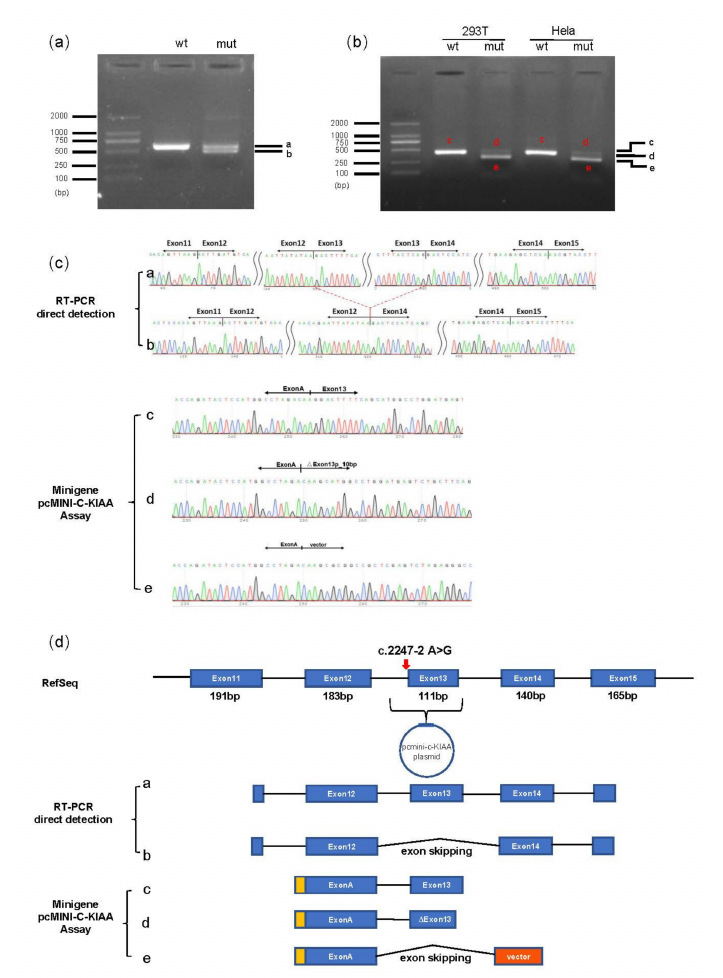
Figure 4. Blood RT-PCR and minigene assay analysis of the KIAA0825 c.2247-2A>G variant: ( a ) Elec- trophoresis results of the RT-PCR products with the mother’s peripheral leukocytes, the band ampli- fied from the normal control (wt) was labeled as a and the bands amplified from the mother (mut) were named as a and b. ( b ) RT-PCR electrophoresis results of the minigene assay. Bands from the WT and c.2247-2A>G constructs were labeled as c, d and e, respectively, both in HeLa and 293T cells. ( c ) The corresponding Sanger sequencing results of excised bands of a, b from the blood RT-PCR and excised bands of c, d, e from the minigene assay. ( d ) The diagram of alternative splicing events observed in the blood RT-PCR and minigene assay. The alternative splicing events from the mather (mut) are labeled as a and b. The alternative splicing events from WT and the c.2247-2A>G constructs in minigene were labeled as c, d and e. Red arrow indicates the variant